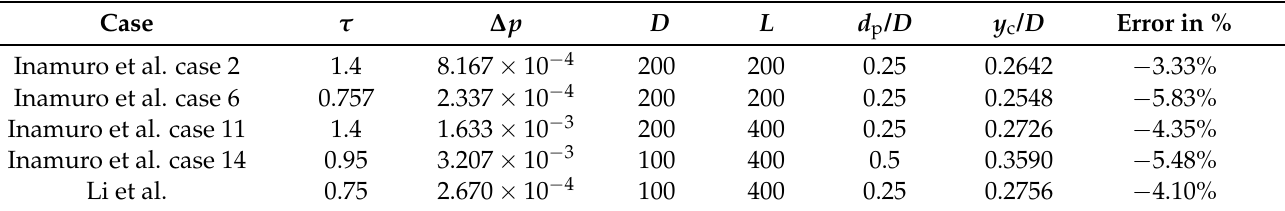
Table 8. Parameters of the simulations investigating the tubular pinch effect along with the results for multiple cases according to Inamuro et al. [36] and the one described by Li et al. [35].